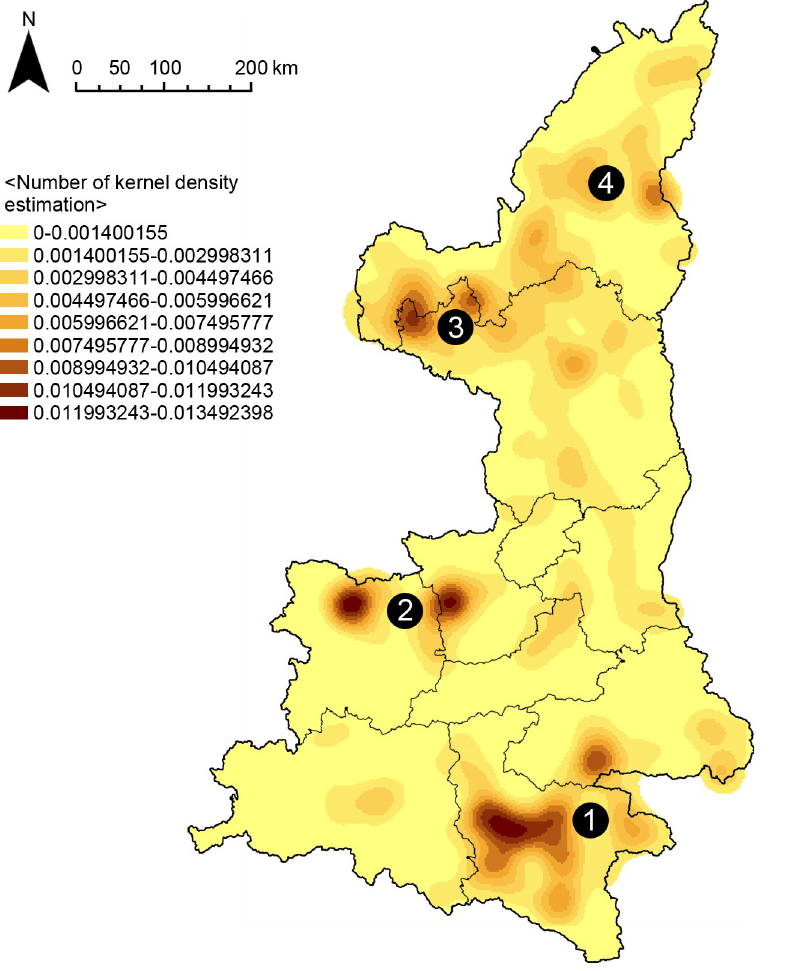
Fig 6. Kernel density estimation